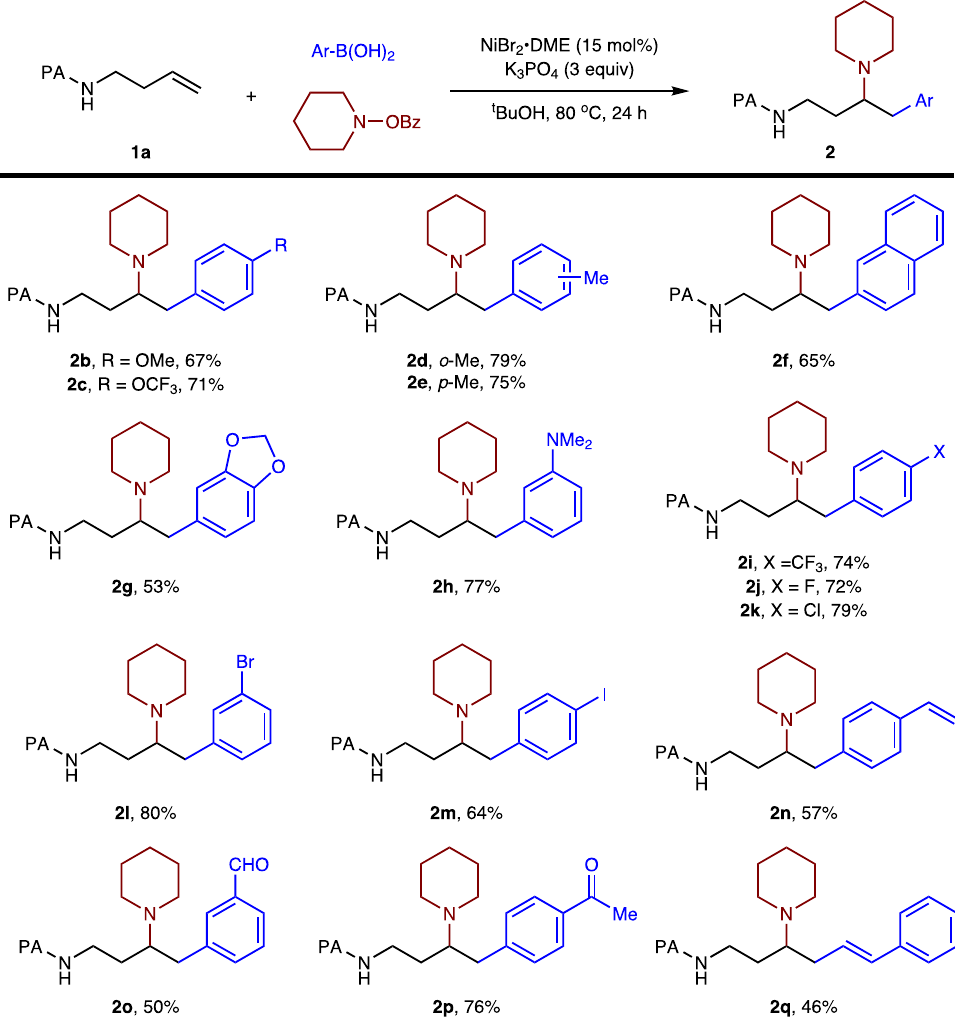
Fig. 3 Scope of arylboronic acids. Reactions conditions: 1a (0.2 mmol), ArB(OH) 2 (3 eq), piperidino benzoate (2 eq), t BuOH (2